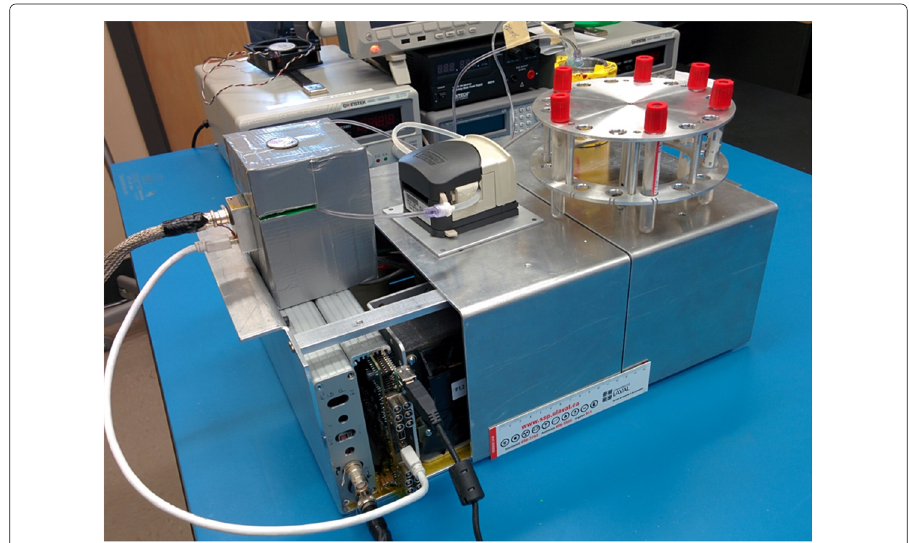
Fig. 7 Setup used for calibration with circulating